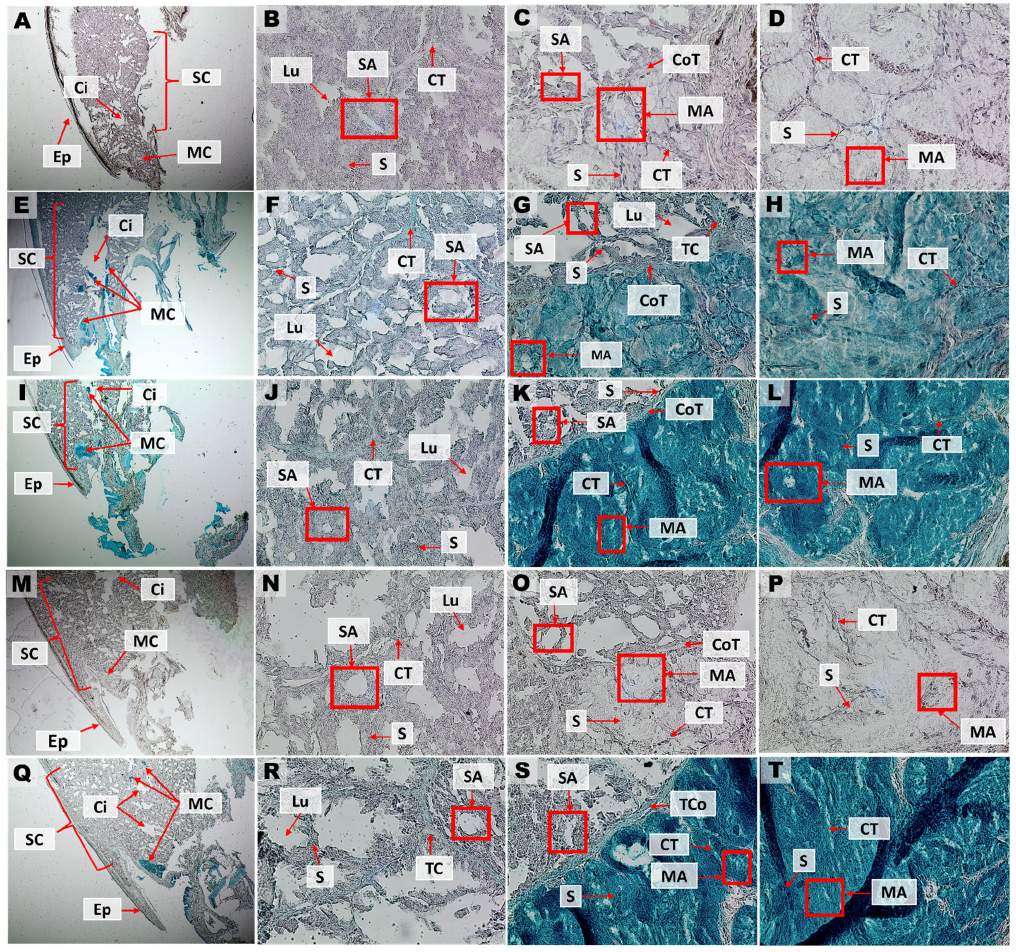
Figure 10. Histology and histochemistry of transverse cross ‐ section from G. ch. chilensis venom gland. ( A – D ) Hematoxylin and eosin, ( E – H ) Alcian Blue 3% acetic acid, ( I – L ), Alcian Blue 1% chlorohydric acid, ( M – P ) PAS, ( Q – T ) PAS–Alcian Blue. Magnification: 4× for ( A , E , I , M , Q ) and 40× for the rest of the images. Abbreviations: Ci = cistern; CoT = connective tissue; CT = collector tube; Ep = epithelium; Lu = lumen; MA = mucous acinus; MC = mucous cells; S = septum; SA = serous acinus: SC = serous cells. All images are from an adult specimen (female, HCMPB07).